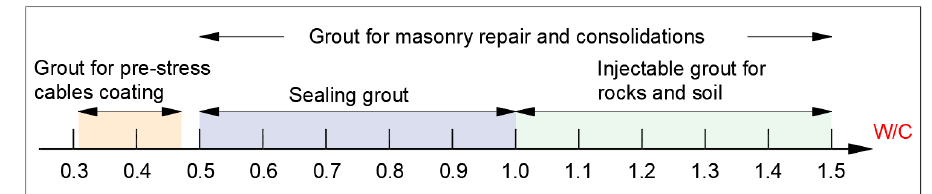
Figure 1. Schematic water–cement ratio (W/C) depending on the application.